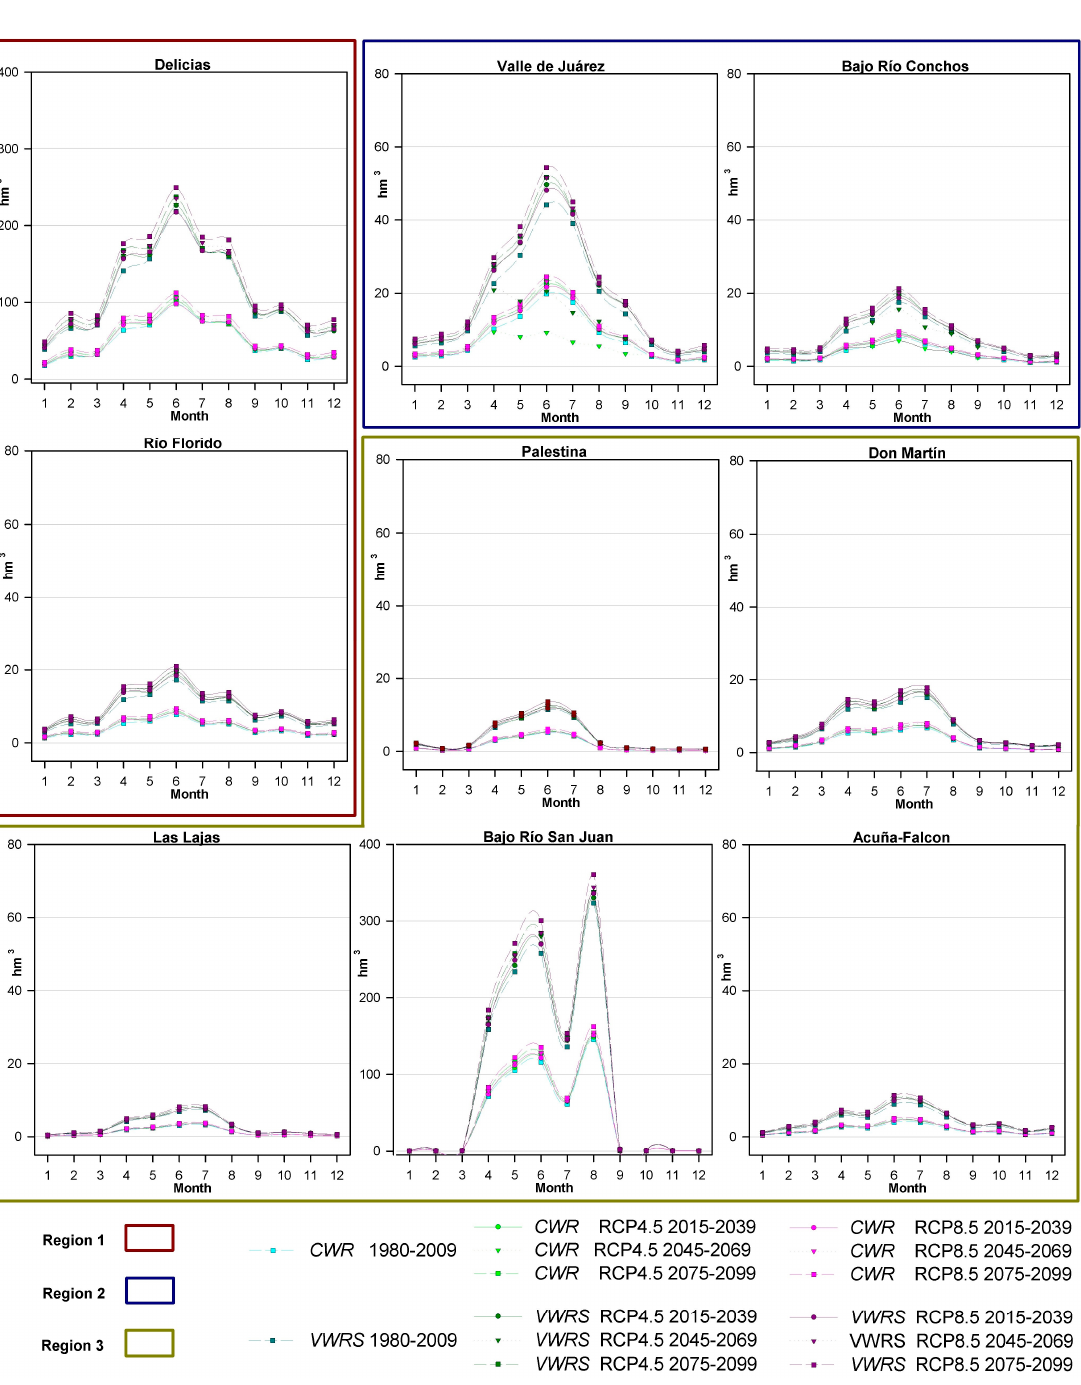
Figure 9. Monthly changes across the ID regions in crop water requirements ( CWRs ) and volumetric water requirements of the sources ( VWRS ) for the 1980–2009 baseline period in comparison to the RCP4.5 and RCP8.5 climate change scenarios projected for 2015–2039, 2045–2069, and 2075–2099 periods based on the harvested crop areas of the 2015–2016 agricultural cycle.